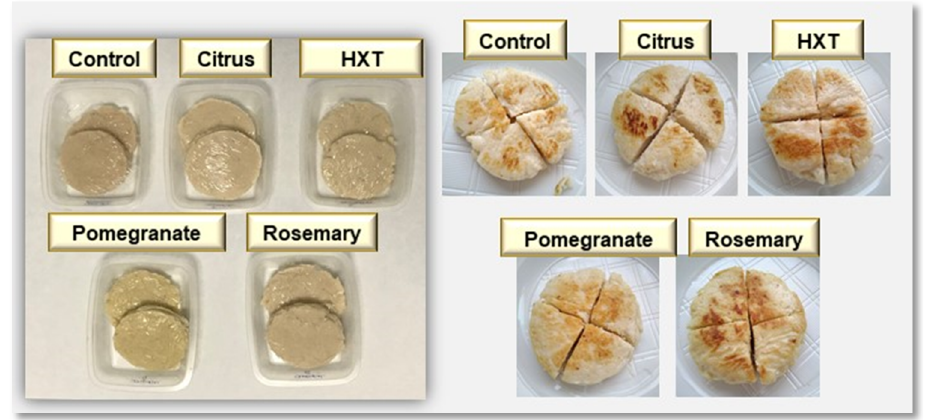
Figure 1. Photographs of raw or cooked fish patty samples .